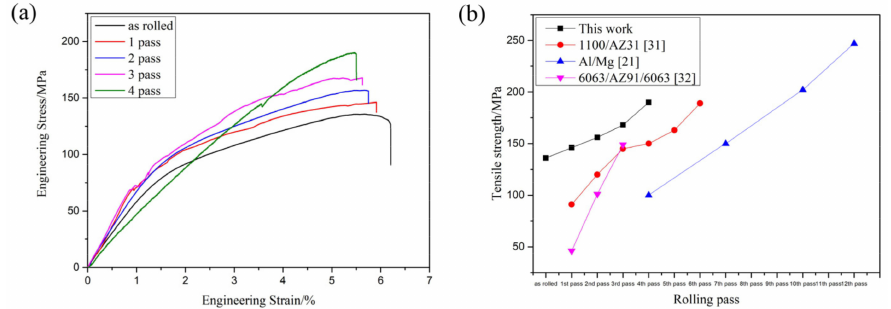
Figure 11. ( a ) Tensile stress-strain curve of Al/Mg composite plate at room temperature in different rolling passes, ( b ) Relevant scholars’ tensile strength data of Al/Mg composite plate [21,31,32]. Table 4. The YS, UTS, and elongation of each sample in Figure 9a. Not Rolled First Pass Second Pass Third